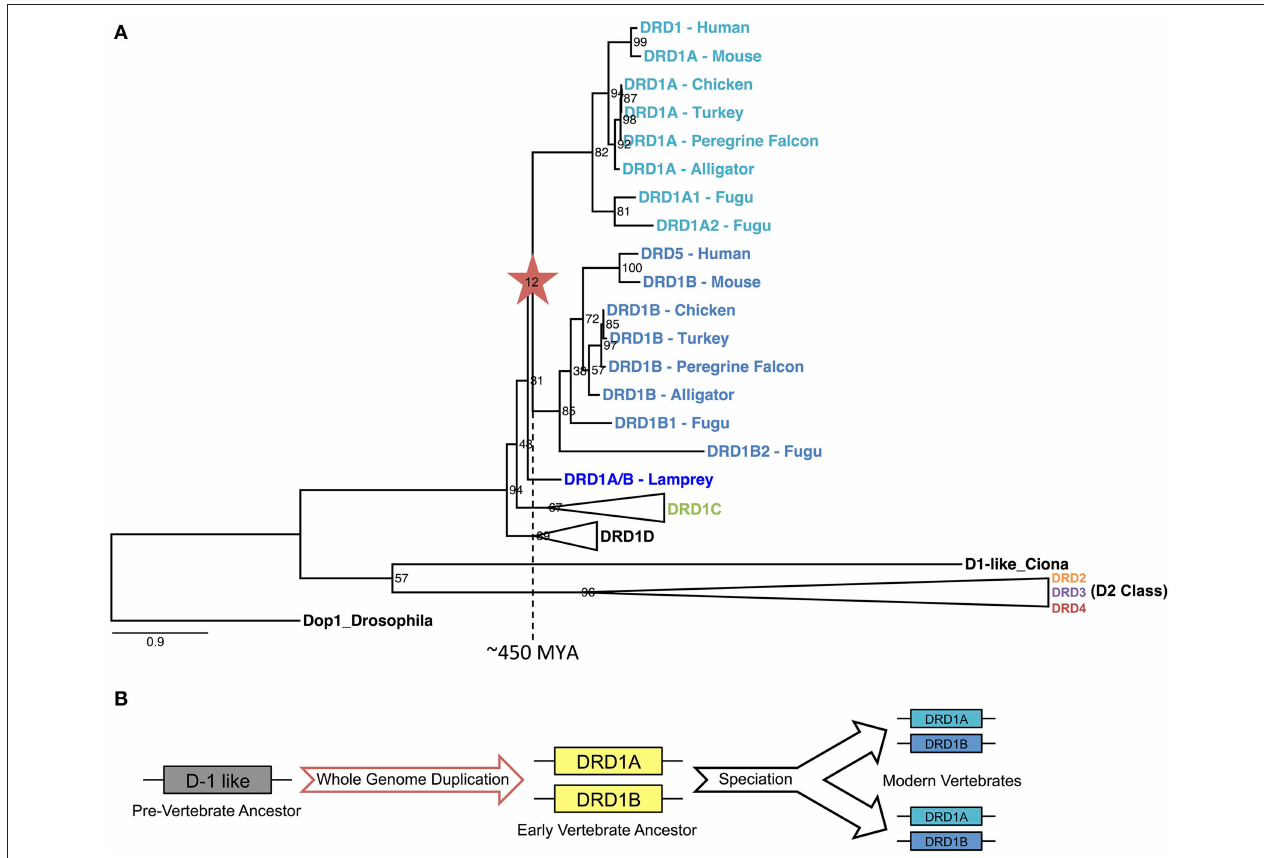
FIGURE 7 | DRD1A/DRD1B evolutionary phylogeny and proposed model. (A) Phylogenetic relationship of D1 and D2 dopamine receptors for two invertebrate (Drosophila and Ciona D1-like) and seven vertebrates (Lamprey, Fugu, Alligator, Turkey, Chicken, Mouse, and Human) species based on protein coding sequences. Bootstrap support values are shown at nodes; branch lengths (substitutions/changes per site) are shown proportionally. DRD1C, DRD1D, and all D2 clades are collapsed for clarity, but expanded clades may be found in Supplemental File 3: Figure S5. Note that fugu has an independent whole genome duplication. (B) Illustrated model of DRD1A/DRD1B evolution, based on events inferred from the evolutionary